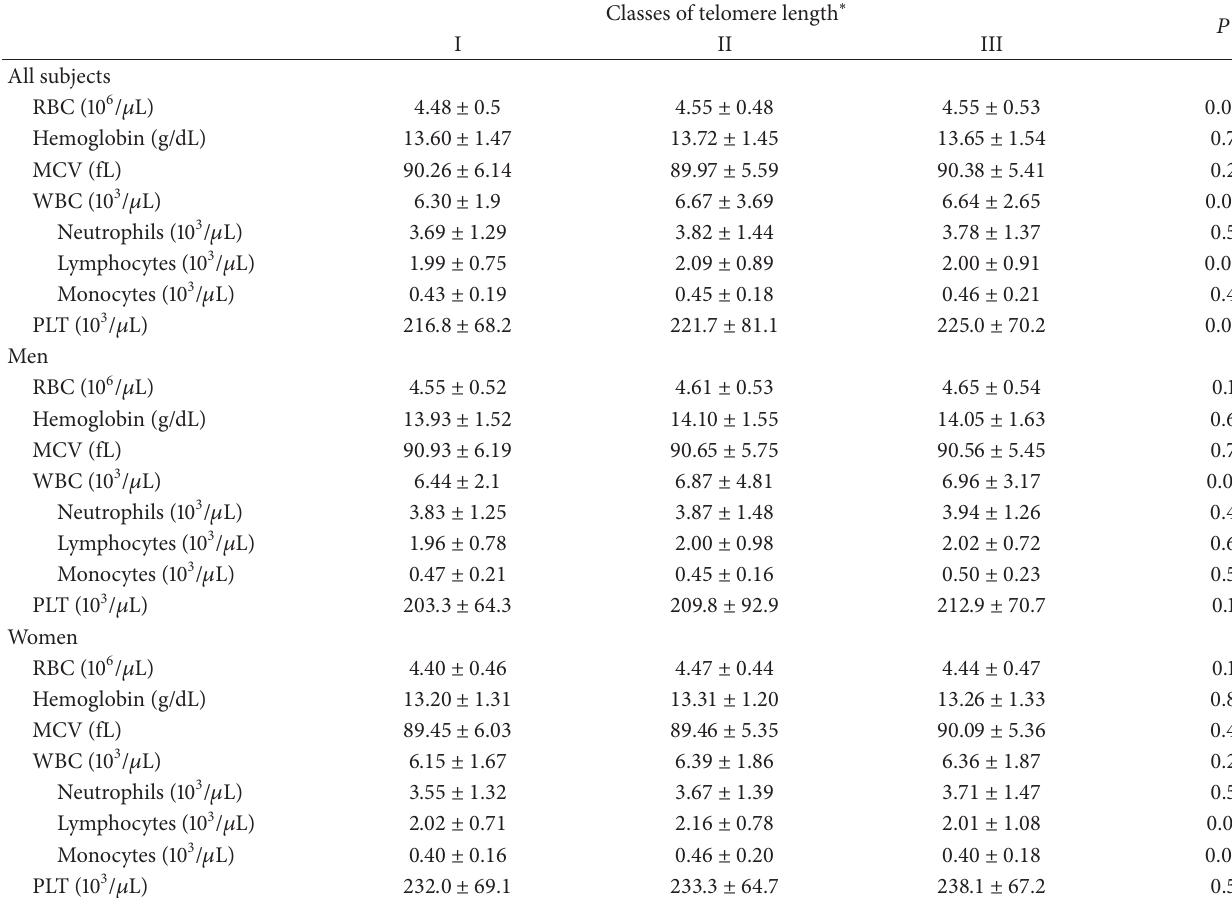
Table 2: Mean values of blood cell counts according to telomere length class (defined by distribution-derived